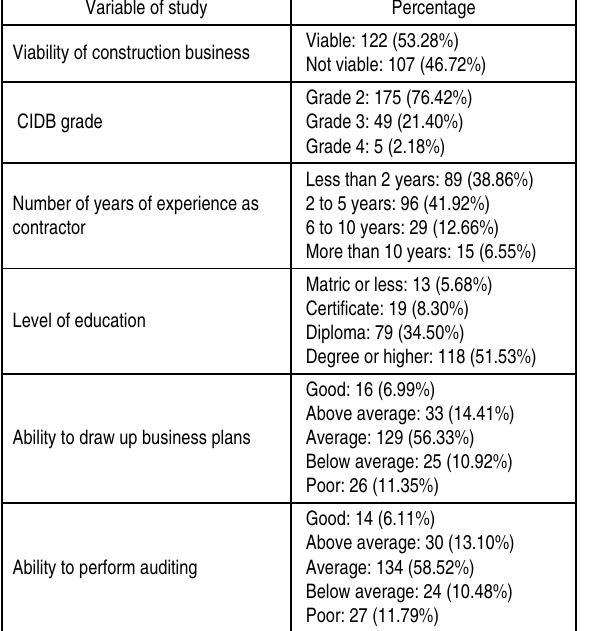
Table 2. Number of respondents selected for